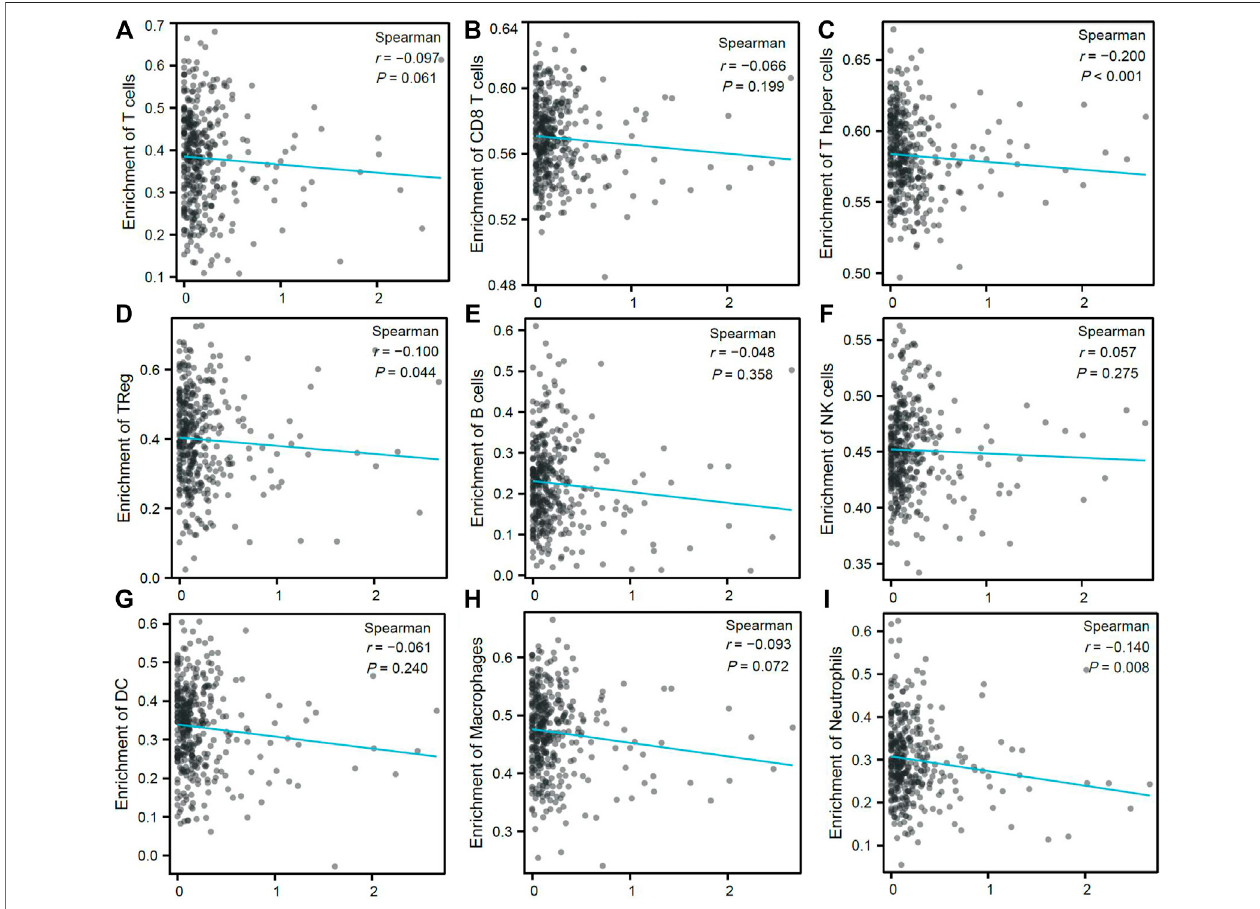
FIGURE7| Correlationbetweenexpressionof CDK6-AS1 andimmunecellin fi ltrationproportion. (A – I) Correlationbetweenexpressionof CDK6-AS1 andssGSEA inferred immune cell in fi ltration of T, CD8+T, T helper, T reg , B, NK, DC, macrophage, and neutrophil cells.